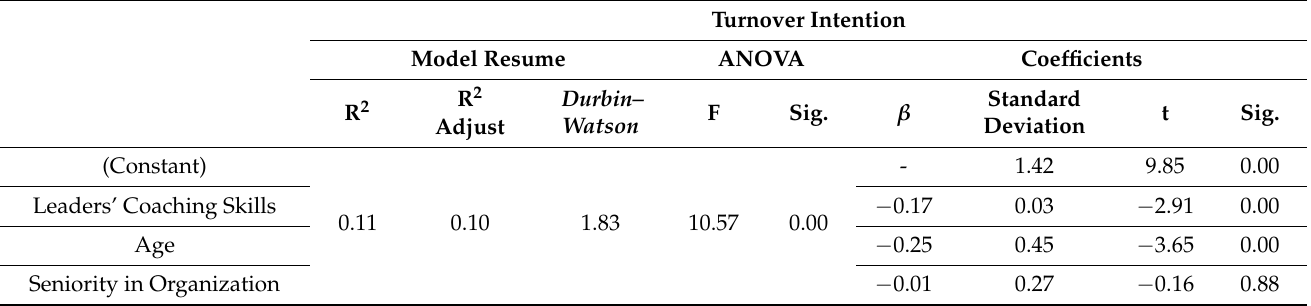
Table 3. Regression (X = Leaders’ coaching Skills and Y = Turnover